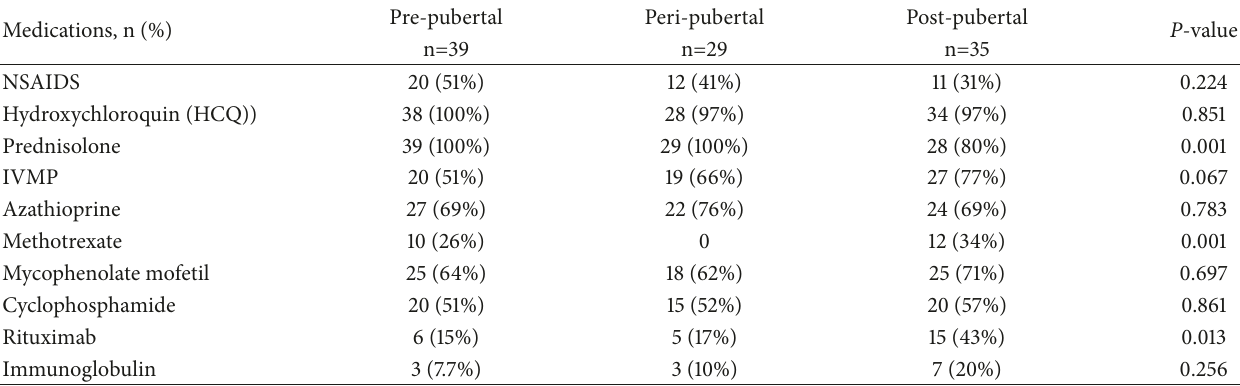
Table 4: Medications of systemic lupus erythematosus (SLE) patients according to age at onset of disease. Medications, n